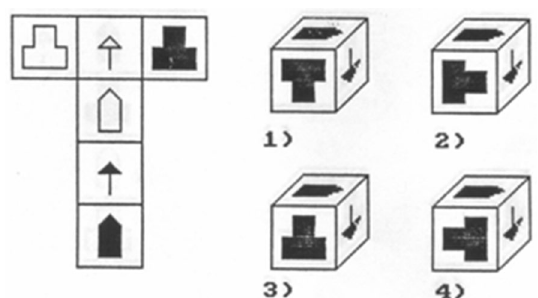
Fig. 2 An item for the spatial learning ability